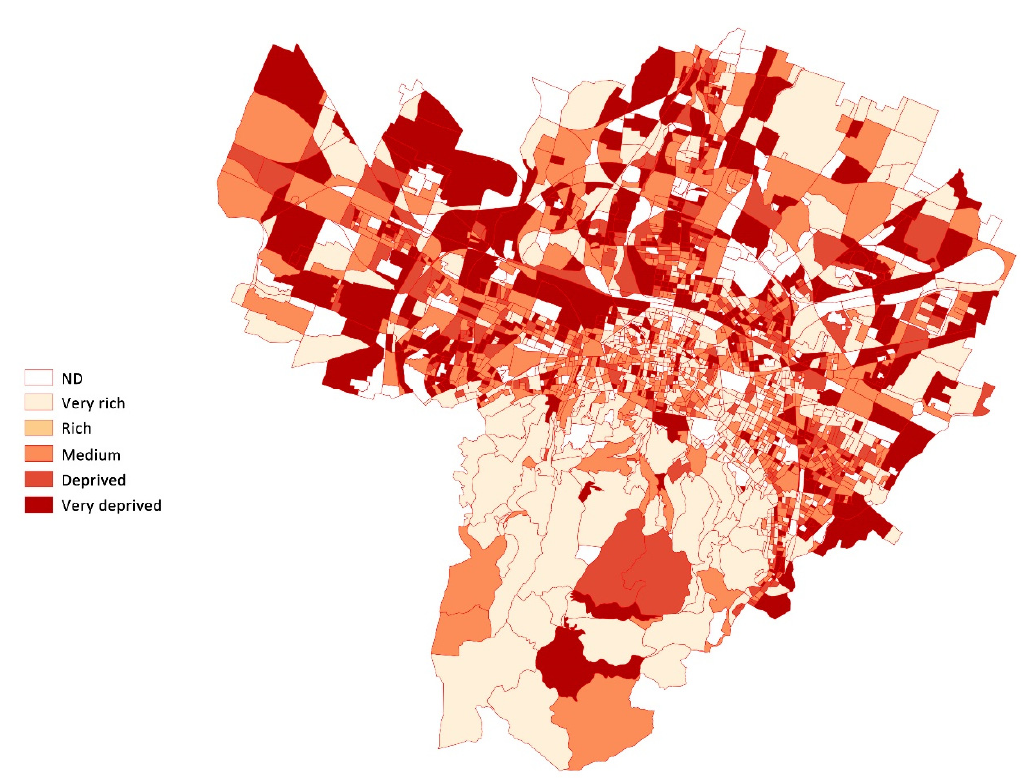
Figure 2. Map of the distribution of the deprivation index, Bologna.